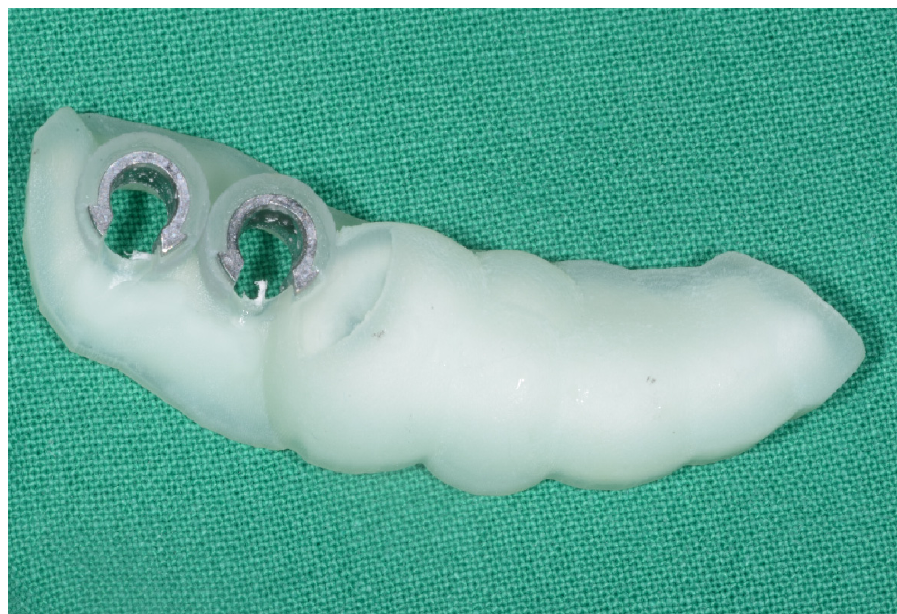
Figure 1. 3D printed surgical guide for pilot-guided implant surgery.